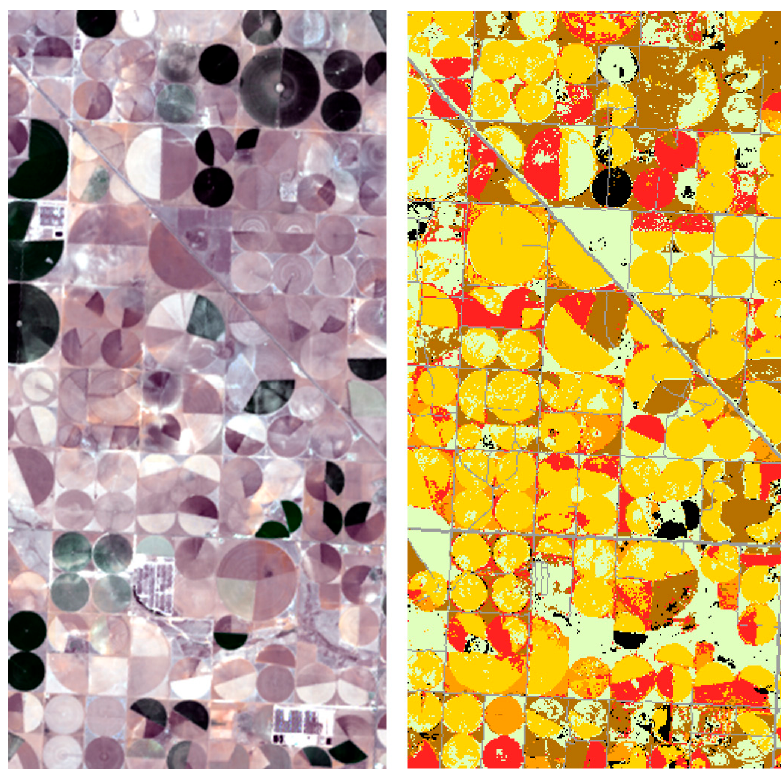
Figure 4. Texas (500 × 250 pixels). Yellow = corn (38.32%); brown=winter wheat (14.35%); gray = developed or open space (4.92%); pale green = grassland or pasture (23.48%); orange = sorghum (5.36%); red = cotton (11.16%); black = background (CDL classes corresponding to ≤ 2% of the study area).